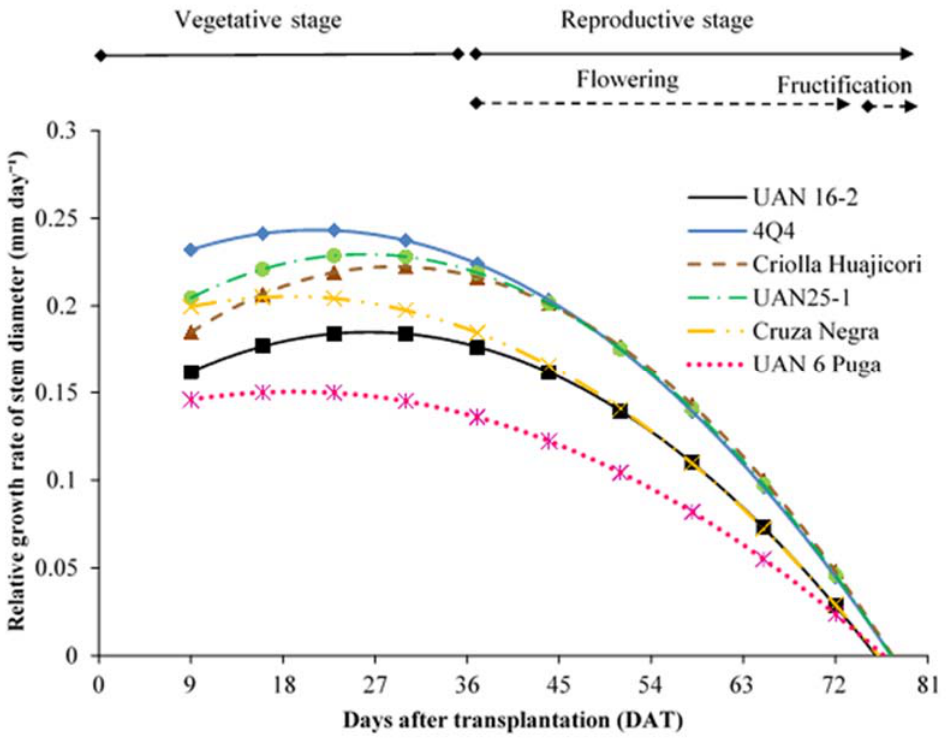
Figure 2. Relative growth rate of stem diameter of roselle cultivars, RGRSD, as a function of time. Estimated values from models (Table 1).